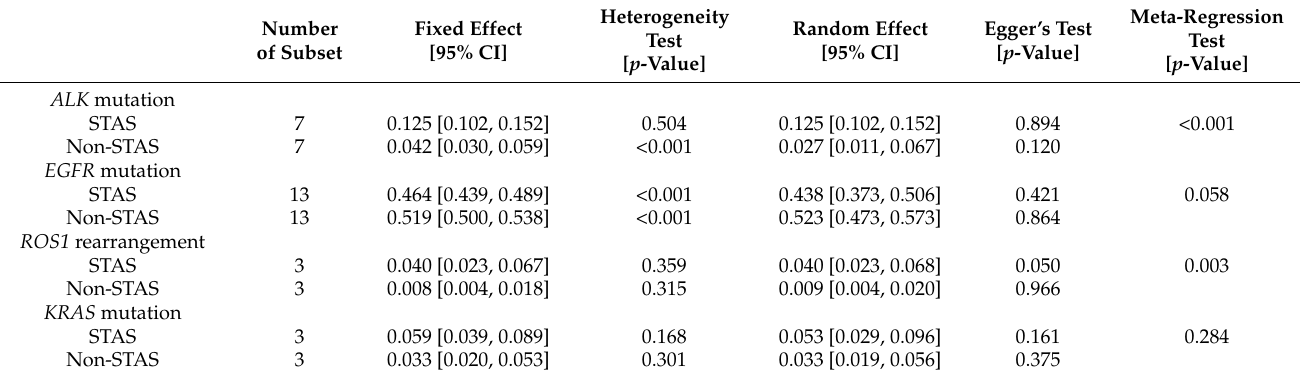
Table 4. Comparisons of genetic mutation between lung cancers with STAS and non-STAS. Number of Subset